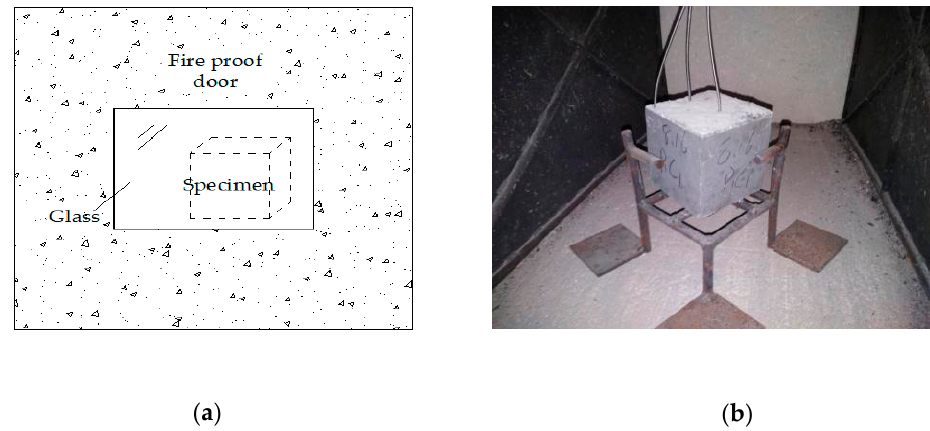
Figure 1. The test equipment: ( a ) the self-made fire-proof door and ( b ) steel frame.